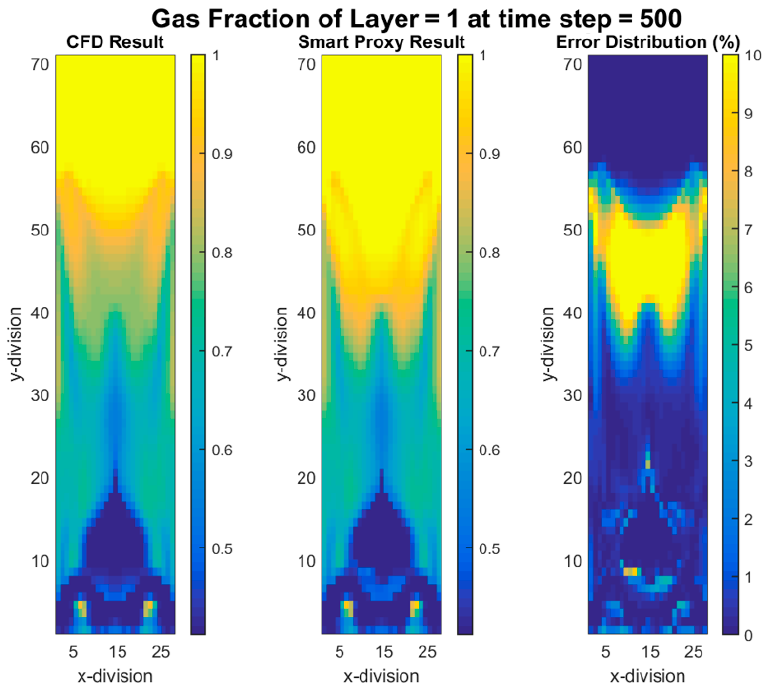
Figure 24. CFD and smart proxy results for gas volume fraction at K = 1 cross-sectional plane.